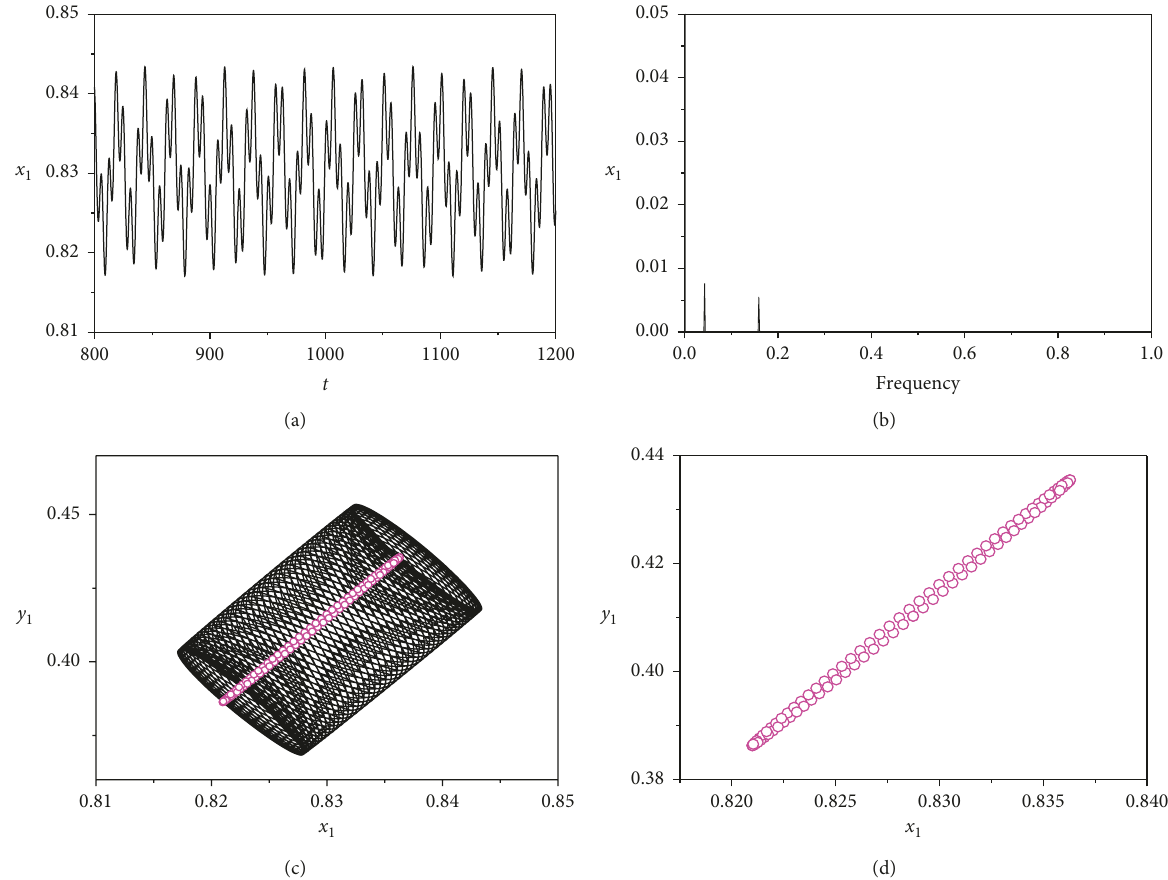
Figure 14: ω � 1.20 and η � 0.27: (a) displacement response; (b) frequency spectrum; (c) rotor orbit; (d) Poincar´e maps.